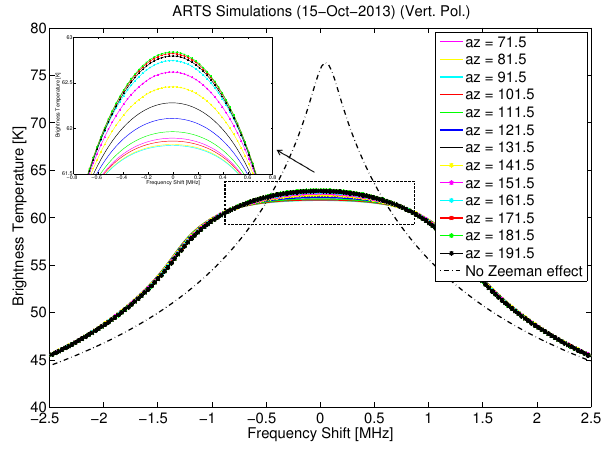
Figure 5. Simulated horizontally polarized spectra on 15 October 2013 with (continuous lines) and without (dashed line) the Zeeman effect.